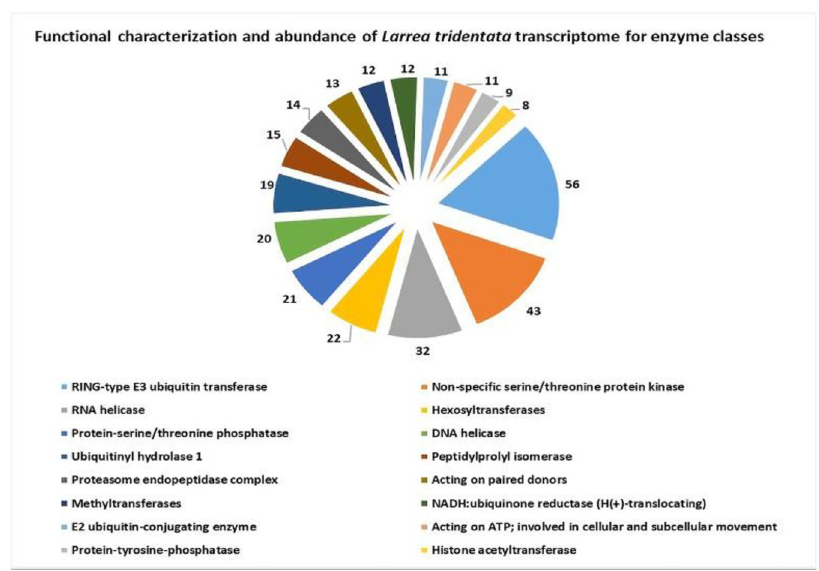
Fig 5. Functional characterization and abundance of L . tridentata transcriptome for enzyme